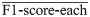
Correlation between F1-score-each¯ of EGS-each and VS-F1-score-each of nEGS-1-each in stage N2 sleep data.Note that after remove one outlier, the F1-score-each¯ of EGS-each was still significantly correlated with the VS-F1-score-each of nEGS-1-each (r = 0.67, P < 10−4). The EGS-each is the expert group standard of each data segment. The nEGS-1-each is the non-expert group standard with definite spindles of each data segment. The F1-score-each¯ was the mean F1 score of EGS-each of each data segment at optimal thresholds. The VS-F1-score-each was the F1 score of nEGS-1-each versus EGS-each.